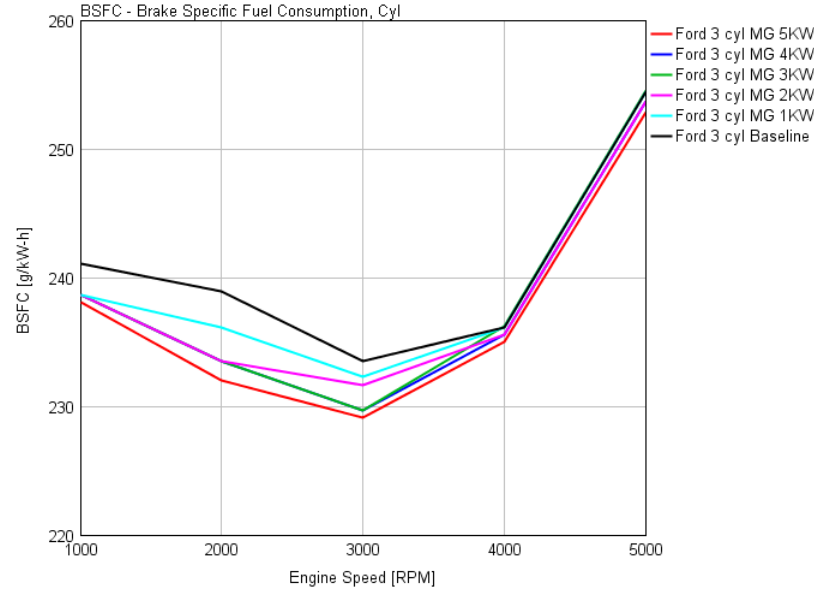
Figure 15. BSFC map results from the engine model.